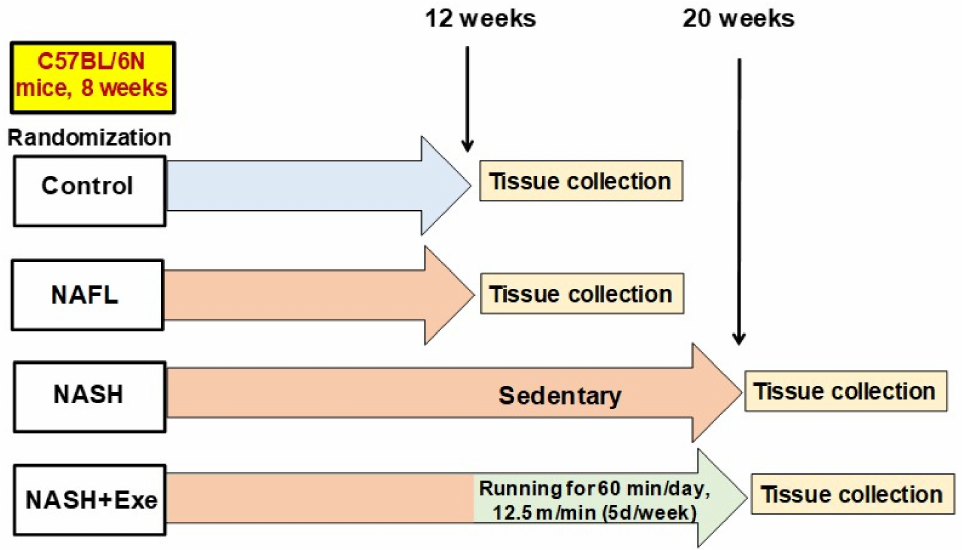
Figure 1. Schematic outline of the study design. Male C57Bl / 6N mice were randomized to one of four groups: (1) the control group ( n = 11) was fed a standard diet and tissues were collected after 12 weeks; (2) the non-alcoholic fatty liver (NAFL) group ( n = 11) was fed a choline-deficient high-fat (CD-HFD) diet for 12 weeks before tissue collection; (3) the non-alcoholic steatohepatitis (NASH) group ( n = 11) received a CD-HFD for 20 weeks and remained sedentary before tissue collection; (4) the NASH + exercise (EXE) group ( n = 11) received a CD-HFD for 20 weeks but with treadmill running at 12.5 m / min imposed from weeks 12 to